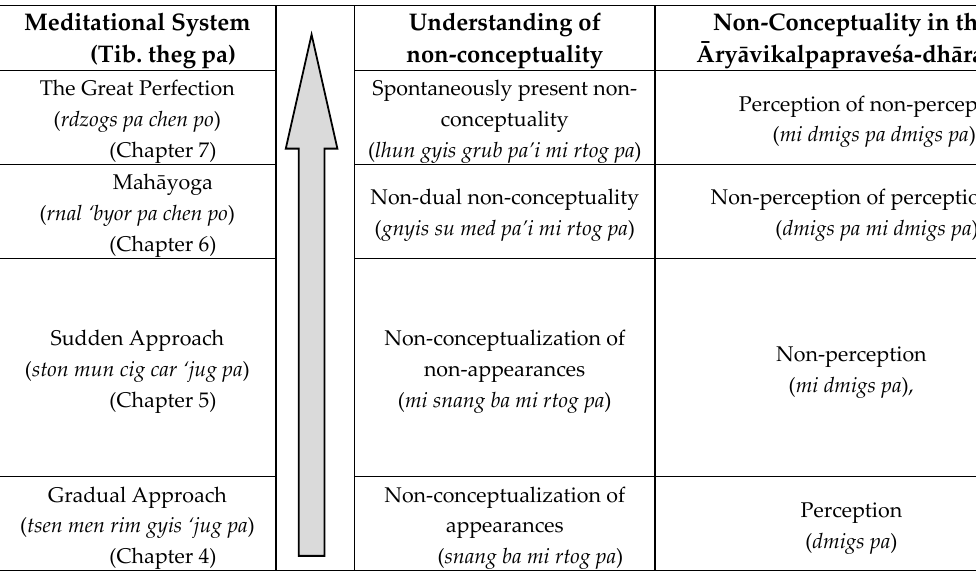
Figure 1. The Lamp for the Eye in Meditation and the Ā ry ā vikalpaprave ś a-dh ā ra ṇ ī .